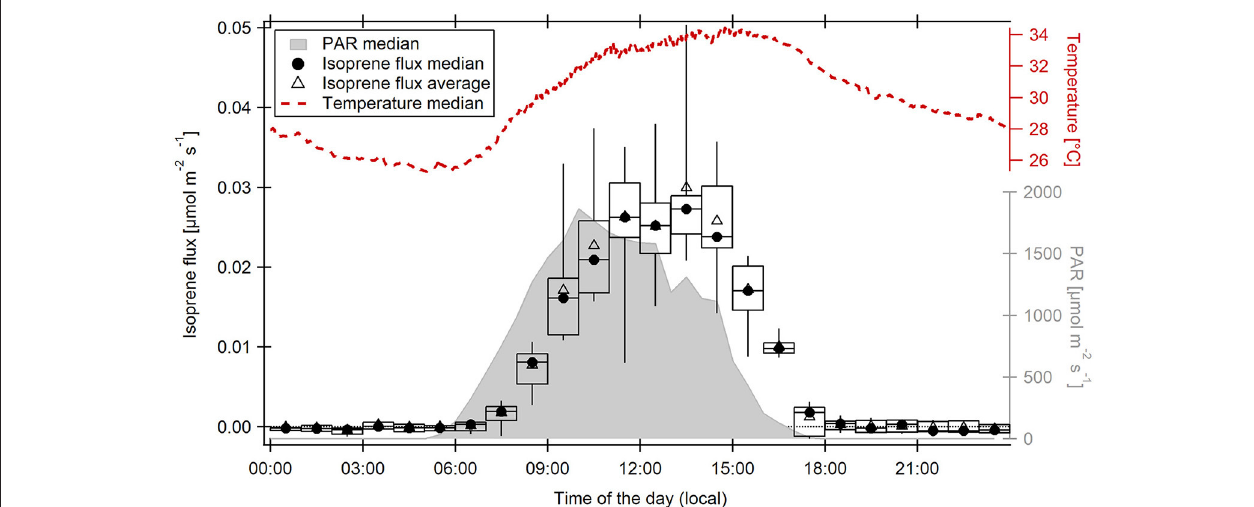
FIGURE 5 | Diel hourly averages and medians of isoprene fluxes measured at 41m above ground level at the ATTO site between November 11 and 23, 2015. Boxes and whiskers represent the 25–75th and 5–95th percentiles, respectively. The diel medians of photosynthetic active radiation (PAR) and ambient temperature measured at the same height are displayed on the right axes.